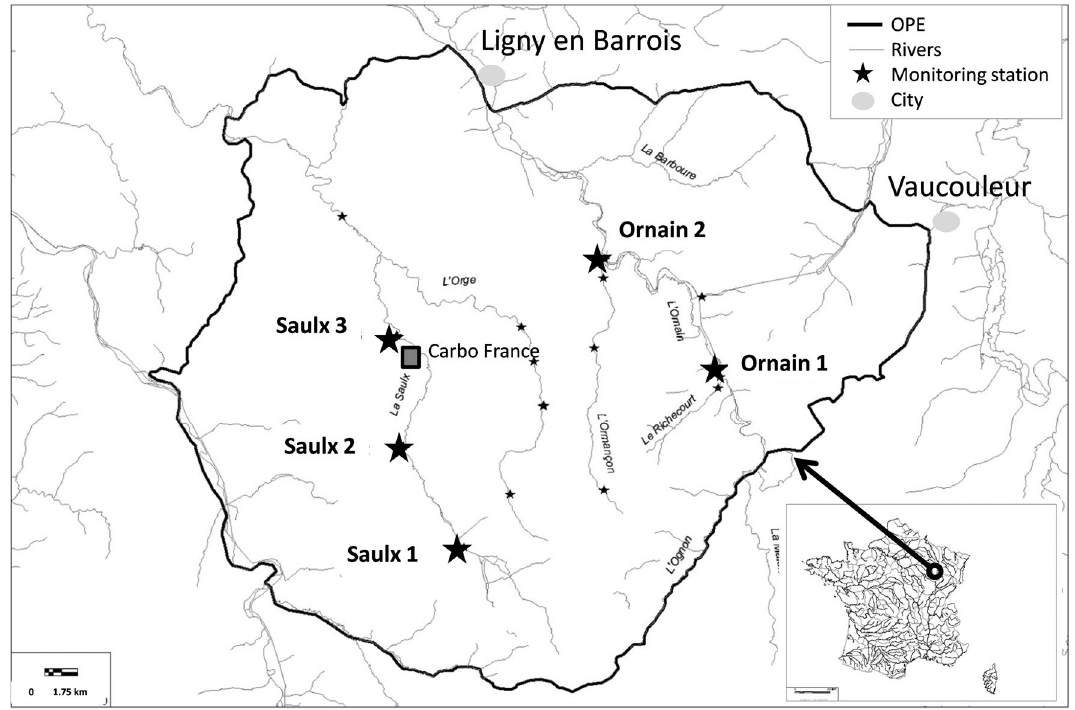
Fig. 1 Localisation of the five monitoring stations within the OPE where continuous measurements and passive samplers were deployed (bigger